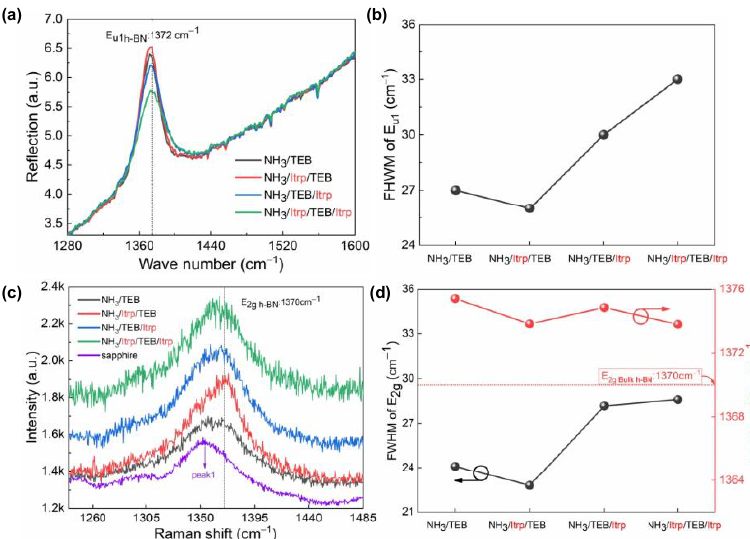
Figure 9. ( a ) FTIR spectra, ( b ) the variations of FWHM of E u1 peaks, ( c ) Raman spectra and ( d ) the variations of FWHM (left axis in black) and location of E 2g (right axis in red) of the h-BN with a similar thickness grown by four FME modes.